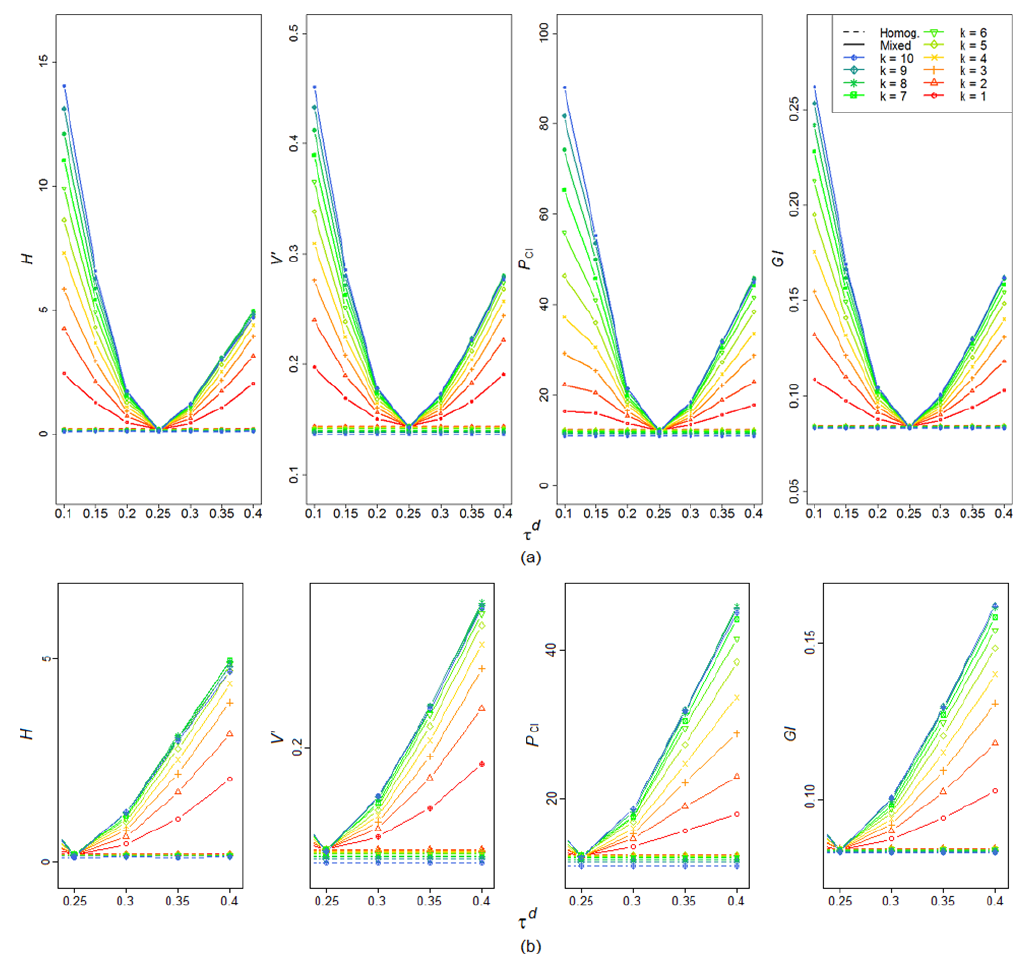
Figure 7. Mean values of the heterogeneity measures over N s = 500 simulations of a given homogeneous region with N = 20 sites, n = 30, and τ R = 0.25, for which k sites are replaced by k discordant sites generated by a GEV with L-Cv τ d , varying τ d in the x axis: (a) full plot; and (b) zoom to the right part of the x